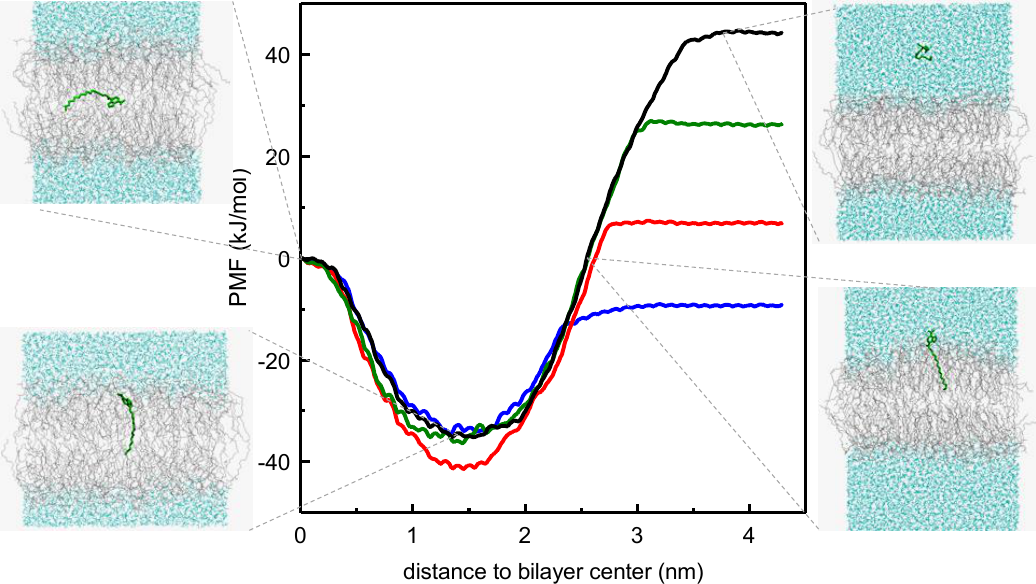
Figure 4. Comparison of PMF profiles calculated for different NBD-C n probes (blue, red, green and black curves correspond to n = 4, 8, 12 and 16, respectively), pulling from the center of the bilayer to the water phase. Illustrative snapshots are shown for NBD-C n at different locations along the reaction coordinate. Adapted with permission from [58]. Copyright 2014 American Chemical Society.